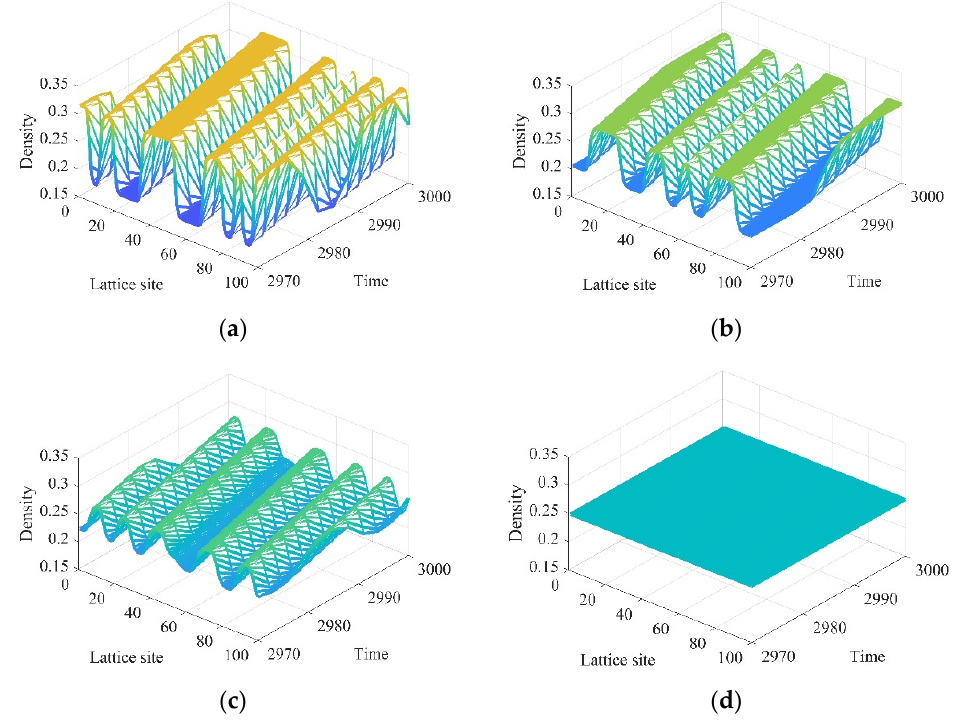
Figure 4. The evolution of the traffic flux for different values of parameter k . ( a ) k = 0, ( b ) k = 0.1, . ( c ) k = 0.15, ( d ) k =